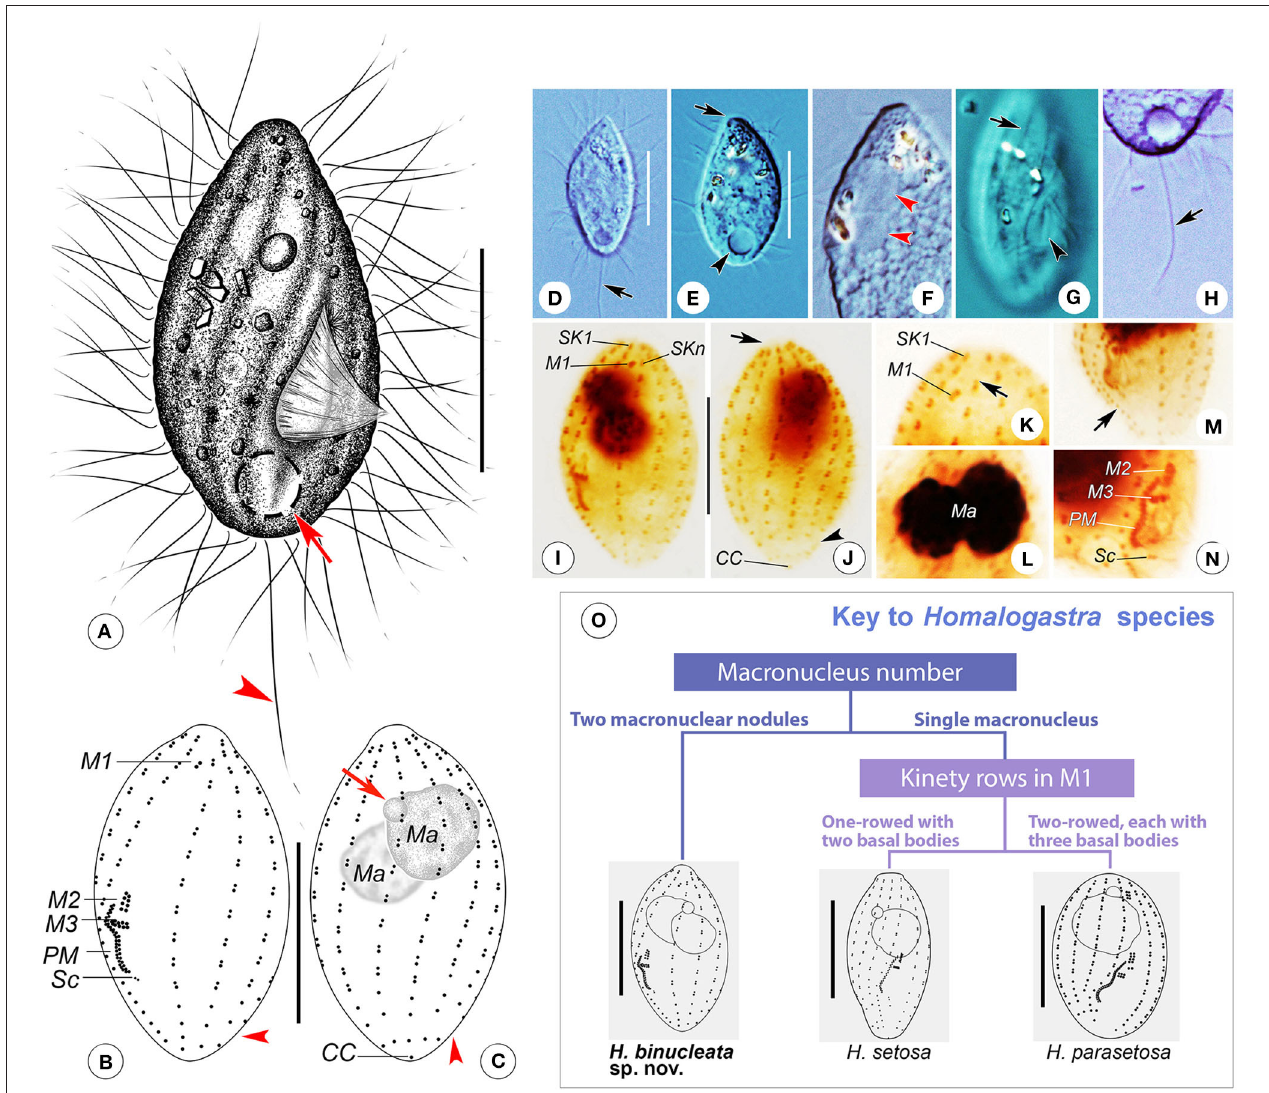
FIGURE 3 | (A–O) Homalogastra binucleata sp. nov. from life (A,D–H) , after protargol staining (B,C,I–N) and key to species of Homalogastra (O) . (A) Right ventrolateral view of a representative individual, arrow shows the contractile vacuole, arrowhead points to the caudal cilium. (B,C) Left ventrolateral (B) and right dorsolateral (C) views of the holotype specimen, arrowheads in B and C indicate the gap between last two basal bodies in somatic kineties, arrow in C points to the micronucleus. (D,E) Cells showing the variations in body shape, arrow in D marks the caudal cilium, arrow in E indicates the apical plate, arrowhead shows the contractile vacuole. (F) Left lateral view of a compressed cell, arrowheads show the two macronuclear nodules. (G) Detail of pellicle, arrow marks the grooves on the ciliary rows, arrowhead points to the buccal field. (H) Detailed view, arrow indicates the caudal cilium. (I,J) Left ventrolateral (I) and right dorsolateral (J) views of the holotype specimen, arrow in J shows the apical plate and arrowhead points to the gap between last two basal bodies in somatic kineties. (K) Anterior ventral side of protargol-stained cell, arrow indicates the shortened anterior end of SKn. (L) Nuclear apparatus, showing the two macronuclear nodules. (M) Posterior half of stained cell, arrow points to the densely arranged monokinetids in SK1. (N) Oral apparatus except for membranelle 1. (O) A species key of Homalogastra . Two congeners are redrawn based on previous studies (Foissner et al., 1982; Pomp and Wilbert, 1988). CC, caudal cilium; M1–3, membranelle 1–3; Ma, macronucleus; PM, paroral membrane; Sc, scutica; SK1, somatic kinety 1; SKn, somatic kinety n. Scale bars: 12 µ m.